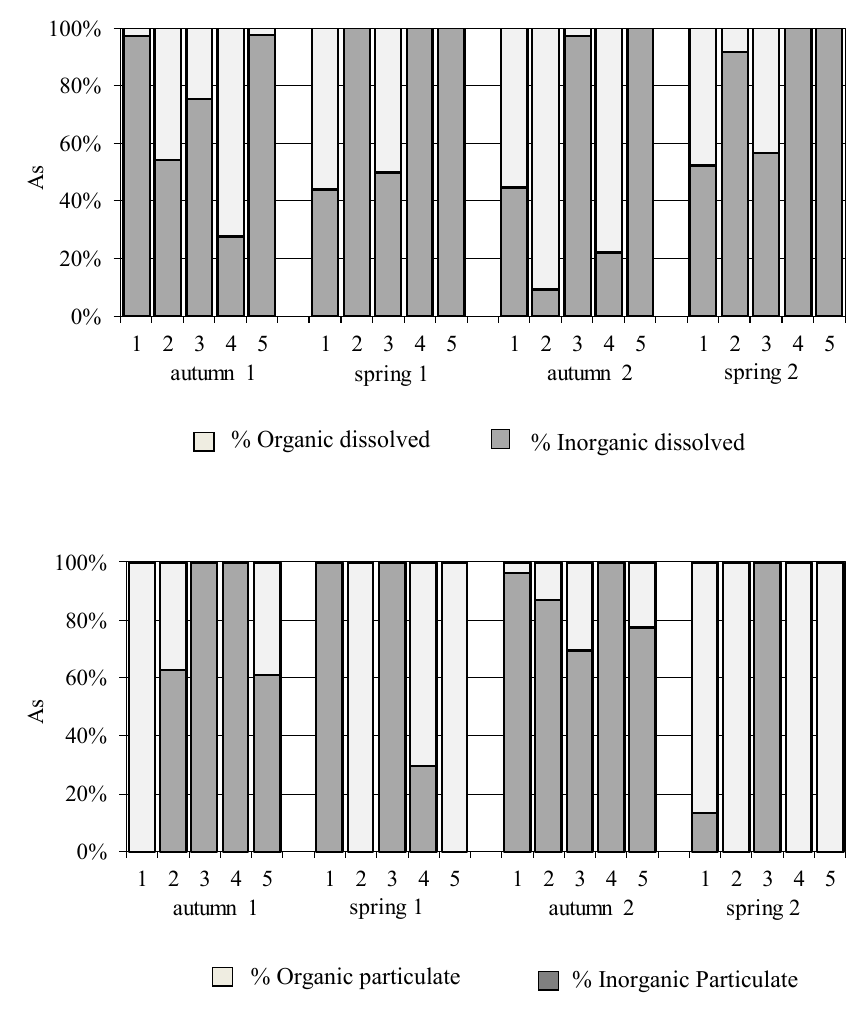
Figure 7. Distribution of inorganic and organic dissolved and particulate As in water samples of Algeciras Bay.